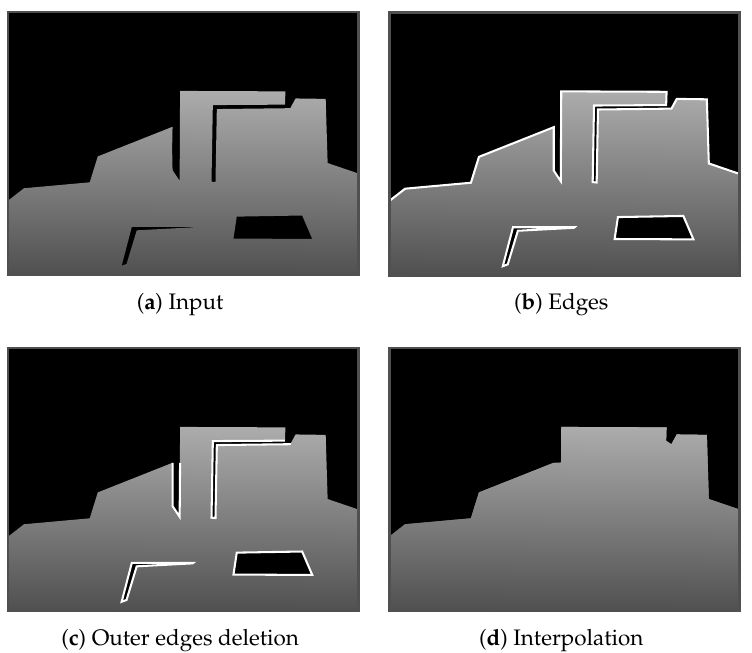
Figure 3. Overview of proposed inpainting approach. ( a ) Black areas indicate areas with no detected depth. ( b ) White lines mark extracted edges. ( c ) Outer edges are eliminated. ( d ) Interpolation using the edges in ( c ).